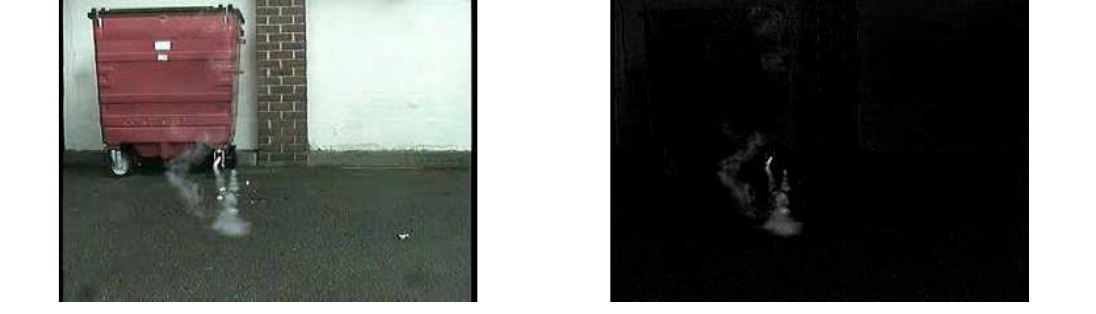
Figure 2. Foreground